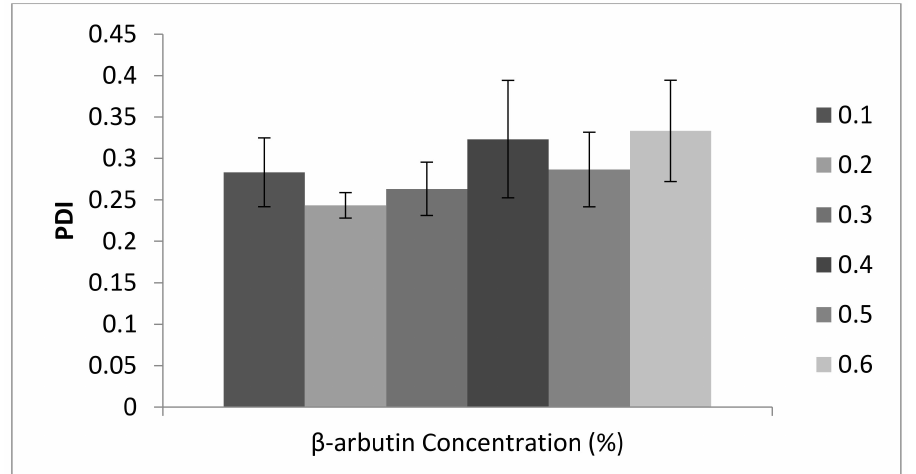
Figure 2. Polydispersity index of 0.1%, 0.2%,0.3%,0.4%, 0.5%, and 0.6% β -arbutin CSNPs. ( n = 3). No significance difference among all